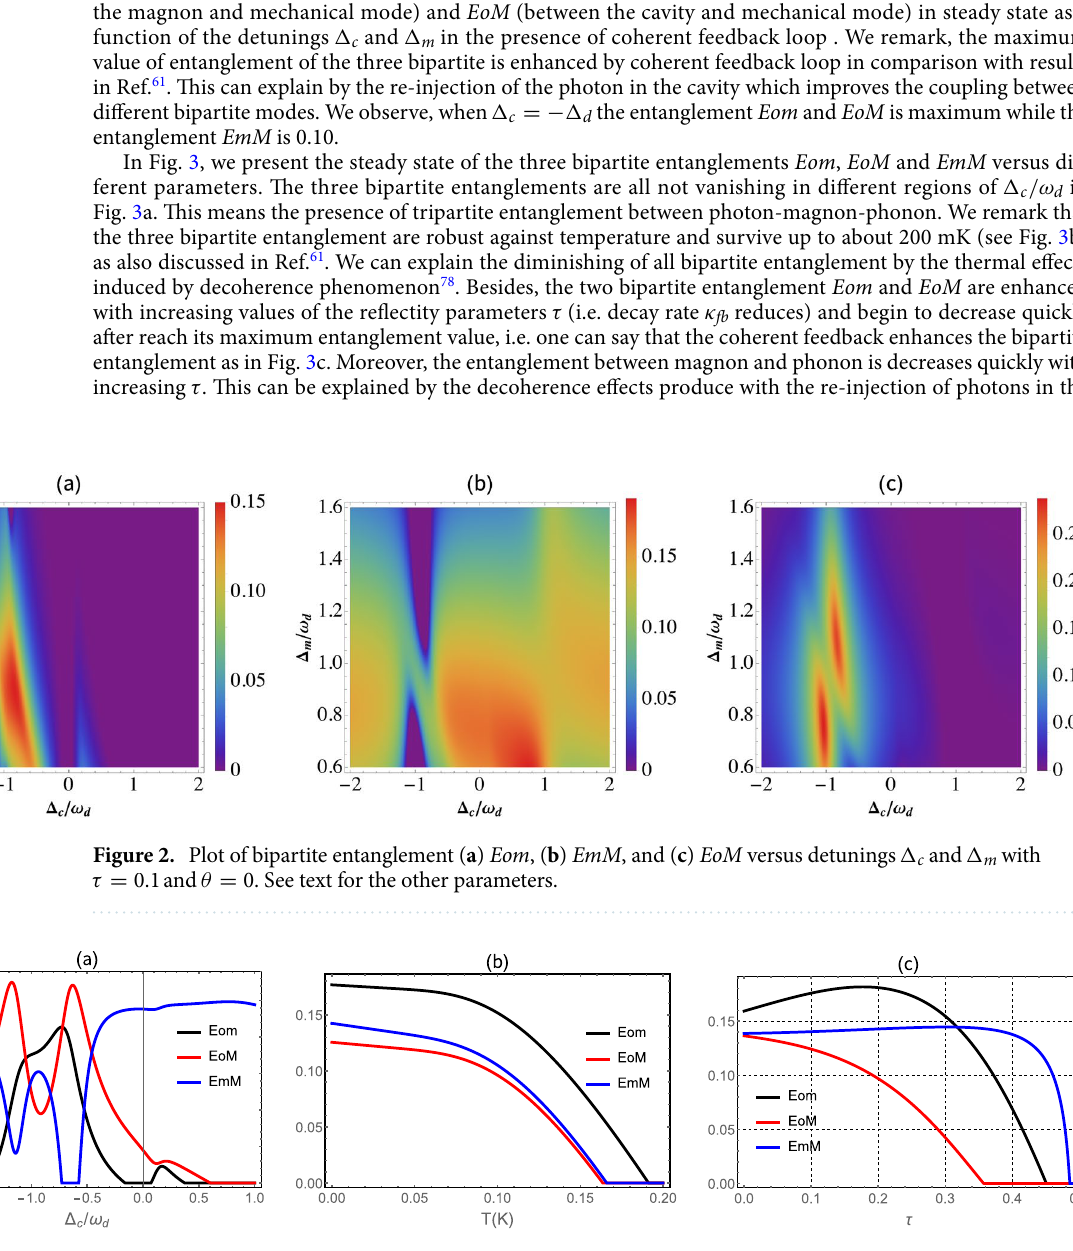
0.1 ( a , b ) � c ω d and = = −